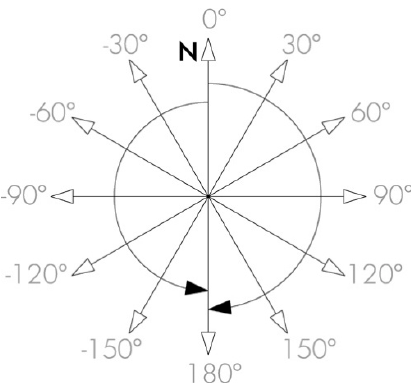
Figure 3. Orientations considered. Energies 2019 , 12 , x FOR PEER REVIEW Table 3. Heating and Cooling patterns for the estimation of energy demand [9].